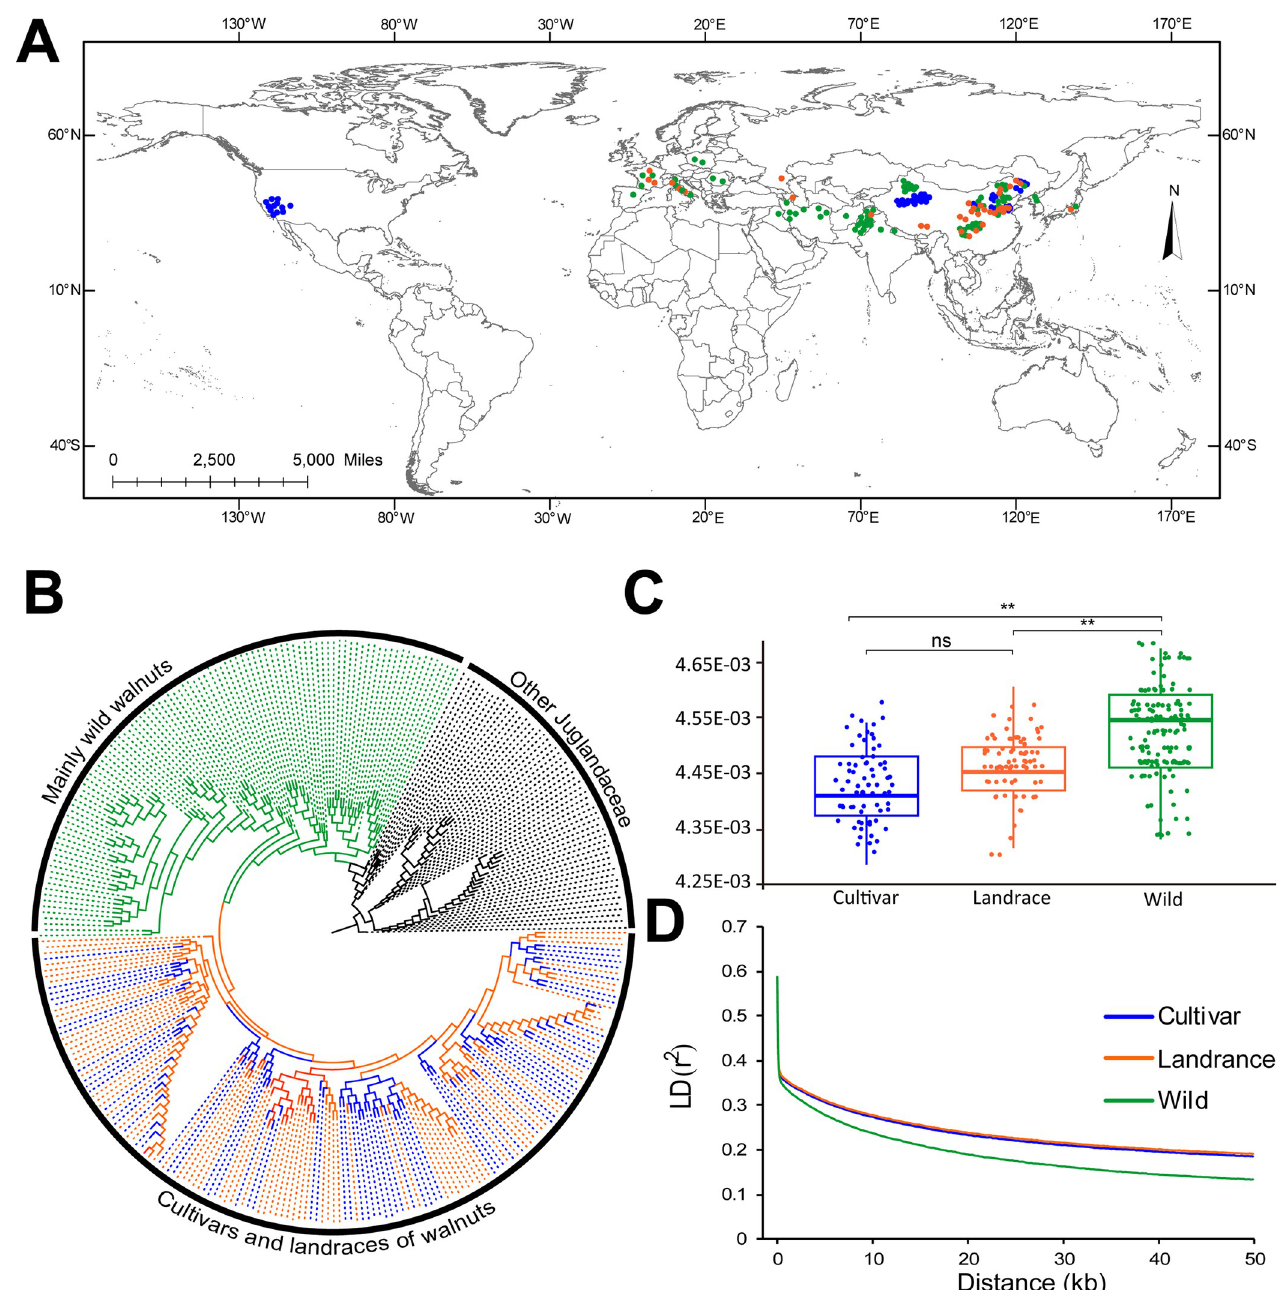
Fig 1. Phylogeny and population genetics of cultivated walnuts and uncultivated walnuts. (A) 309 walnut accessions distribution in different geographical regions. Green: wild; orange: landraces; blue: cultivars; and black: related Juglans species. The basemap and distribution of all sampling points were plotted in ArcGIS v10.2 (ESRI Inc., Redlands, California, USA). The world map was downloaded from the Natural Earth (https://www.naturalearthdata.com/downloads/ 10m-cultural-vectors). The grey line indicates the country region border shape in the map. (B) A neighbor-joining tree of 309 walnut accessions (C) Summary of nucleotide diversity ( π ) across wild walnuts, landraces, and cultivars. (D) Decay of linkage disequilibrium (LD) in different walnut groups. group (YG) had higher nucleotide diversity (6.88 × 10 − 3 ) than the first group (EA, 4.01 × 10 − 3 ) and the fourth group (SA, 5.76 × 10 − 3 ; WA: Iran, Afghanistan, and Iraq,